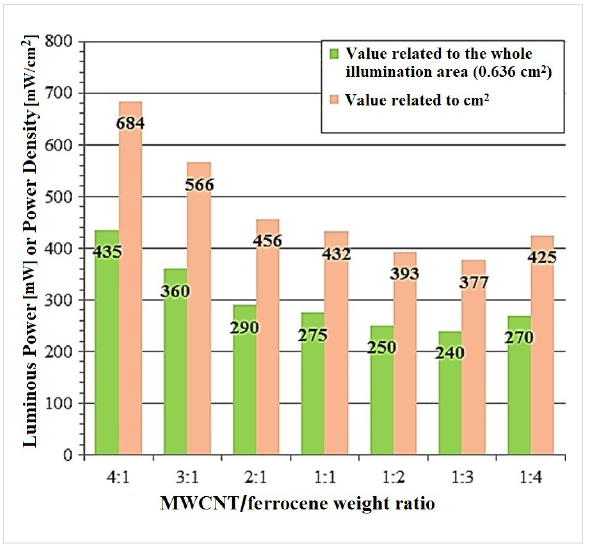
Figure 10: Laser power meter, Spectra Physics, Analog 407A (a) and view of the sensor positioned at the height of the focal point to measure the light spot power (b).